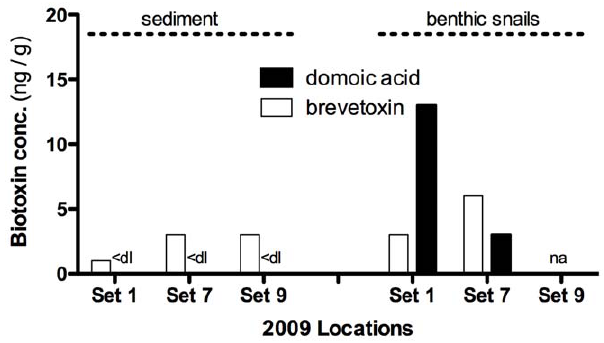
Figure 4. Domoic acid and brevetoxin in Sarasota Bay, FL sediment and benthic snails. Various samples for biotoxin analysis were collected in May 2009 that correspond to dolphin sampling set sites (‘‘Sets’’). Note: ‘na’ represents ‘not available’ and ‘ , dl’ represents ‘below detection limit’. doi:10.1371/journal.pone.0017394.g004 PLoS ONE |